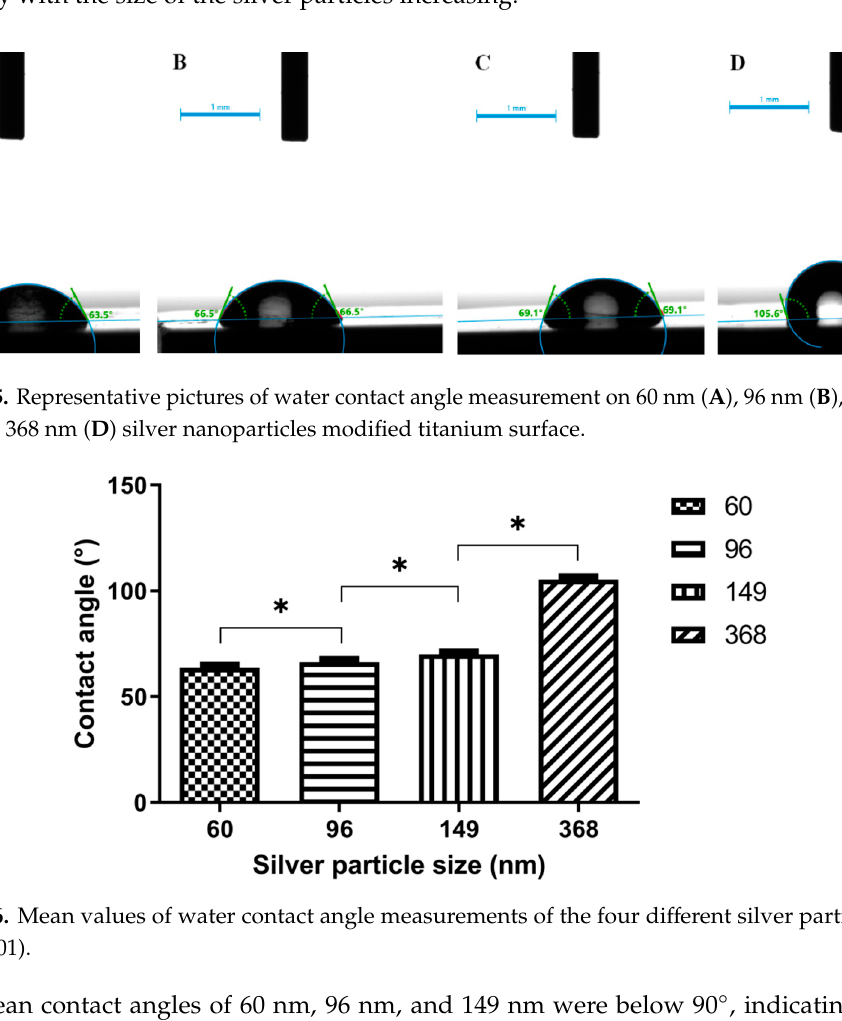
Figure 4. ( A ) Gaussian distribution of the average diameter of AgNPs; ( B ) linear relationship between average nanoparticle diameter and silver layer at T = 600 °C.